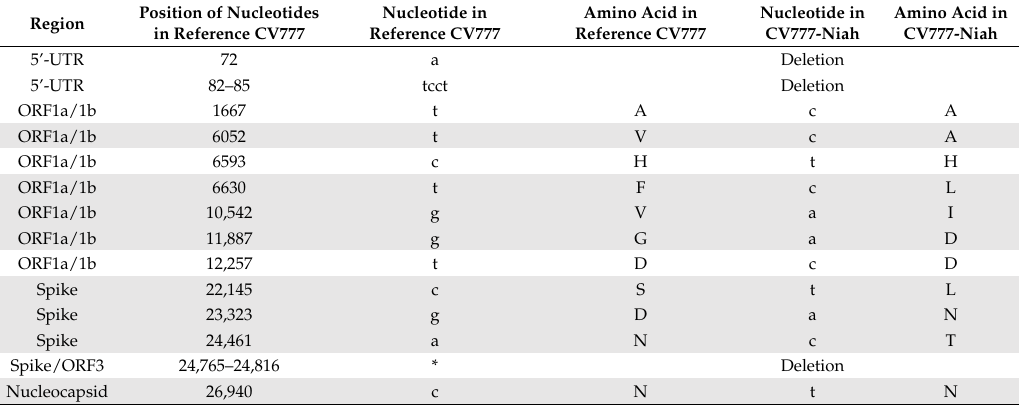
Table 1. Nucleotide and amino acid differences by comparison of the complete genomes between CV777 maintained in National Institute of Animal Health and reference CV777 (GenBank accession number AF353511). Position of Nucleotides Nucleotide in Amino Acid in Nucleotide in Region in Reference CV777 Reference CV777 Reference CV777